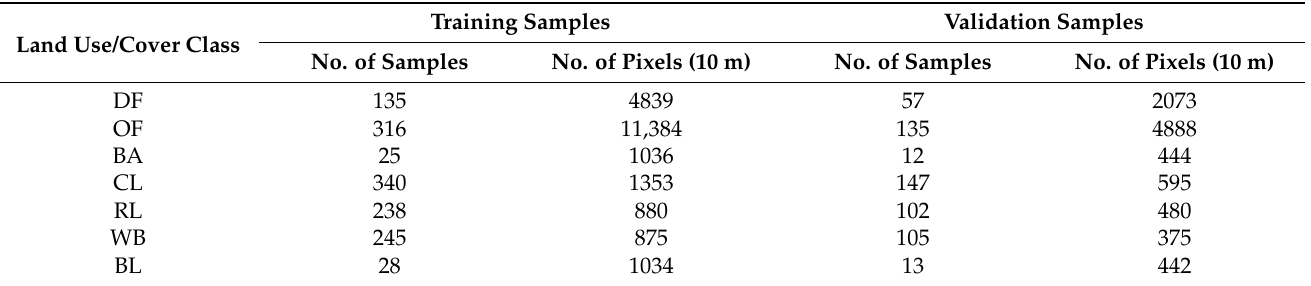
Table 1. Details of the reference dataset for 2022: the number of samples and pixels used for training and validation subsets.